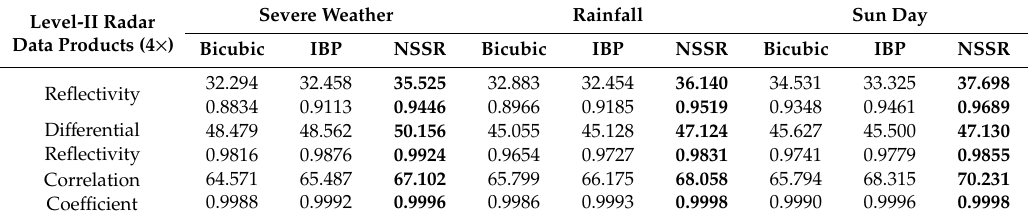
Table 5. Average PSNR (dB) and SSIM results of the reconstructed echo of five groups of level-II XPRAD